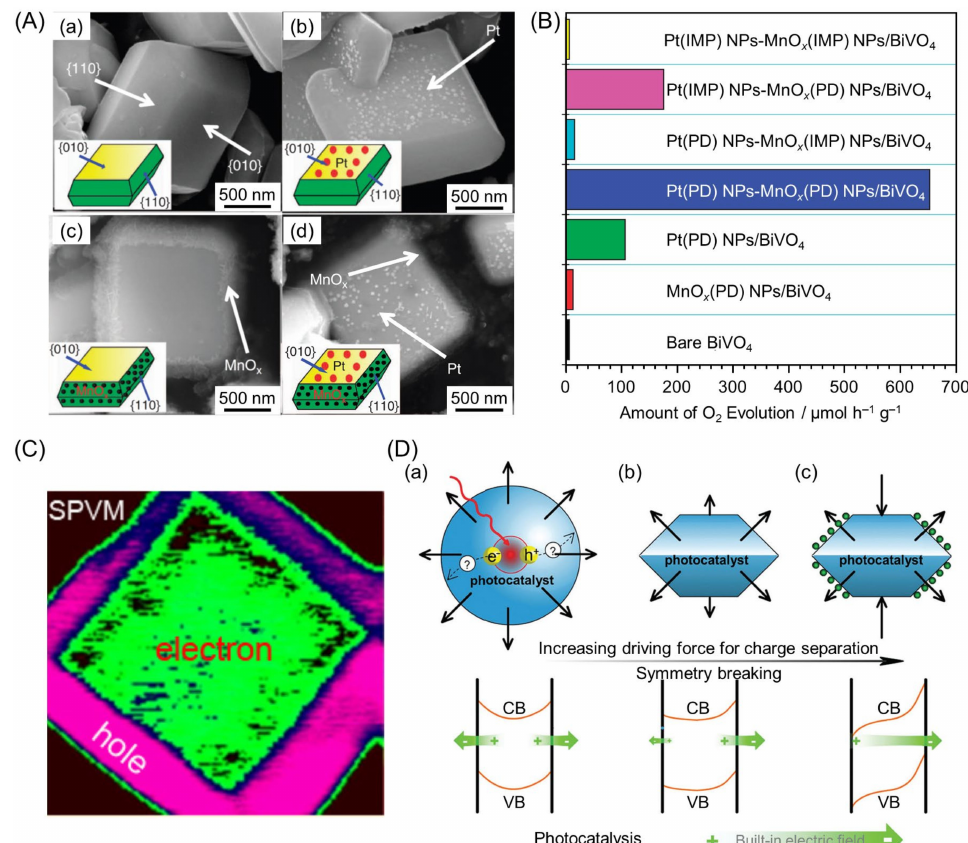
Figure 34. ( A ) SEM images of BiVO 4 with and without metal/metal oxide NPs. ( a ) Bare BiVO 4 , ( b ) Pt(PD) NPs/BiVO 4 , ( c ) MnO x (PD) NPs/BiVO 4 , and ( d ) Pt(PD) NPs-MnO x (PD) NPs/BiVO 4 . Contents of the deposited metals/metal oxides are all 5 wt%. ( B ) Amount of O 2 evolved over each photocatalyst. Reaction conditions: NaIO 3 aqueous solution (150 mL, 0.02 M), Xe lamp (300 W, λ ≥ 420 nm), top irradiation, reaction time of 1 h. (IMP, impregnation method; PD, photodeposition method; contents of the deposited cocatalysts are all 0.1 wt%). ( C ) Spatial distribution of the surface photovoltage signals. Pink and green colors correspond to holes and electrons separated toward the external surface, respectively. ( D ) Schematic illustrations showing the driving force for charge separation in photocatalyst particles with ( a ) symmetric built-in electric fields, ( b ) anisotropic built- in electric fields on different facets, and ( c ) an asymmetric cocatalyst assembly. Reproduced with permission from references [287,295,296]. Copyright 2013 Springer Nature Limited, 2017 American Chemical Society, and 2018 The Royal Society of